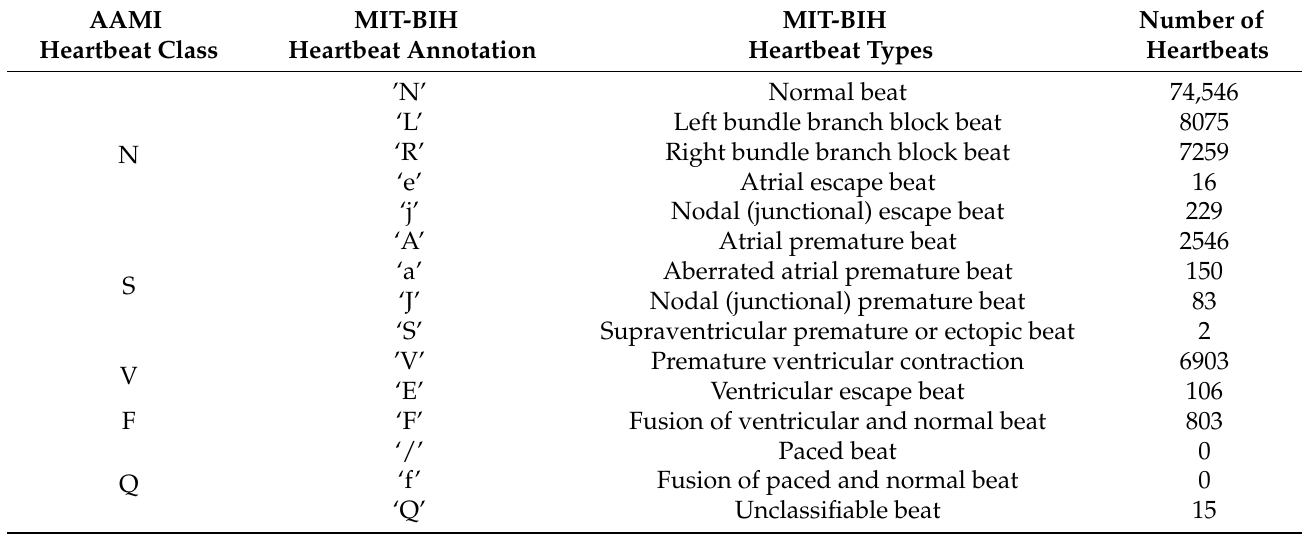
Table 1. AAMI heartbeat classes and corresponding MIT-BIH heartbeat